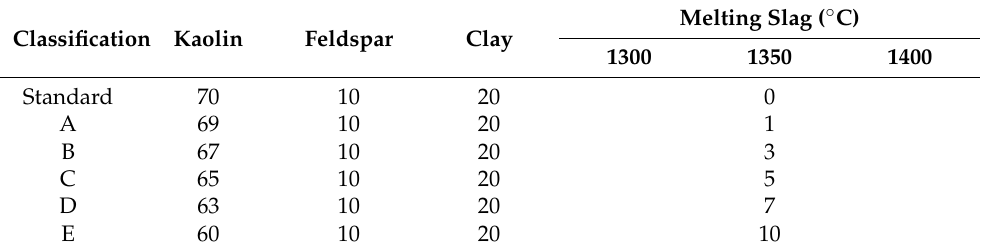
Table 5. Manufacturing Conditions for Clay Bricks.